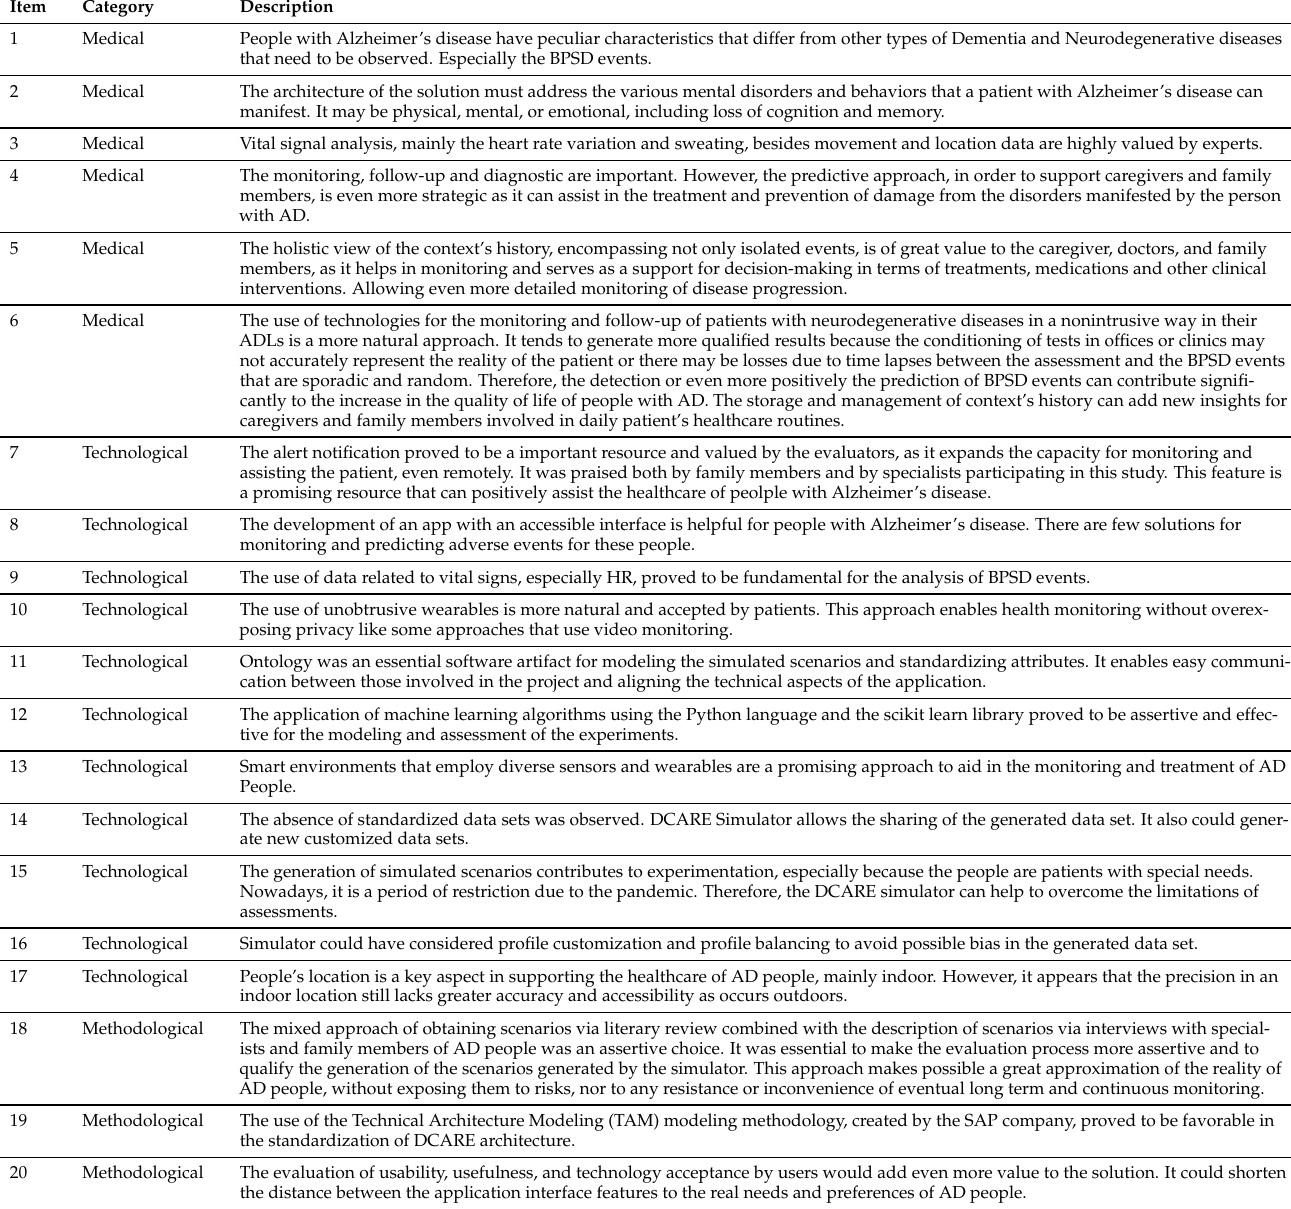
Table 7. Lessons